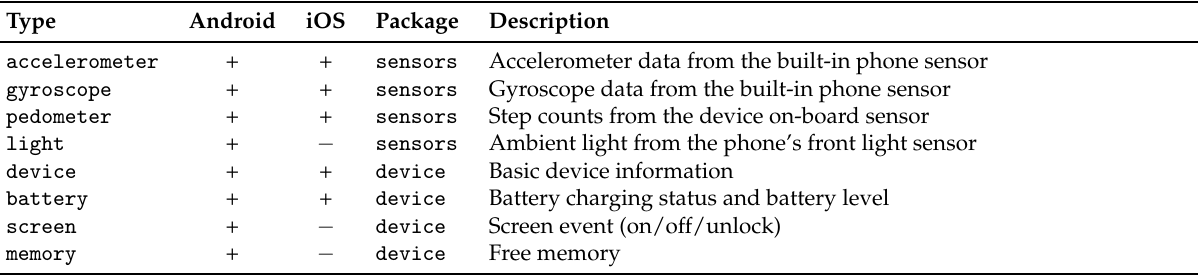
Table A1. Measures available in CAMS, their availability on Android and iOS ( + : available, − : not available), and which package they belong to. The top part lists the sampling packages built into CAMS; the middle part lists the external sampling packages, and the lower part lists sampling packages for wearable devices. The external packages are available for download at pub.dev